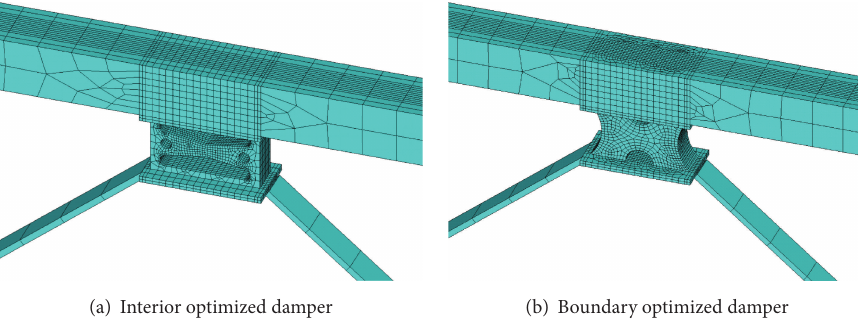
Figure 23: Optimized damper connected with beam.